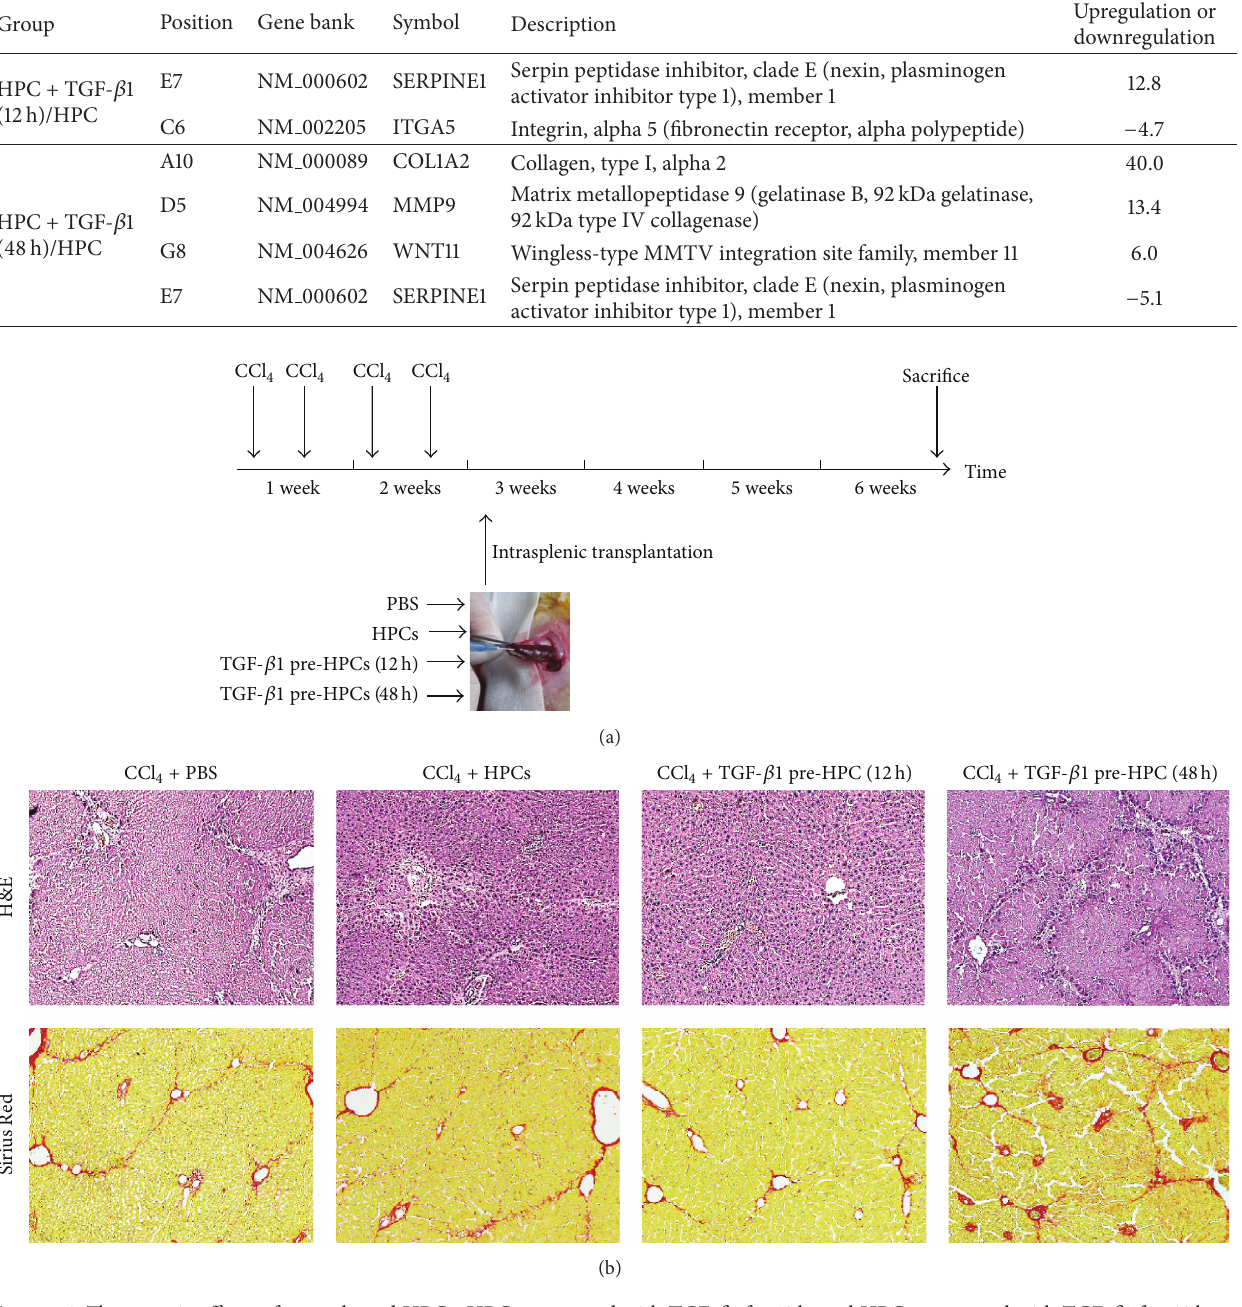
Upregulation or